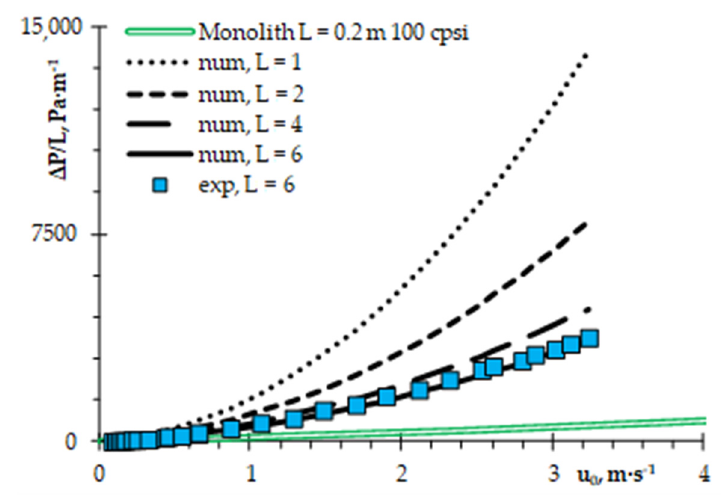
Figure 7. Comparison of numerical results for different channel lengths.